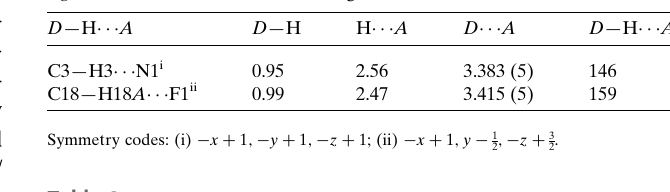
Table 1 Hydrogen-bond geometry (A˚ , (cid:3) ) for (I). Cg 1 is the centroid of the C1–C6 ring.